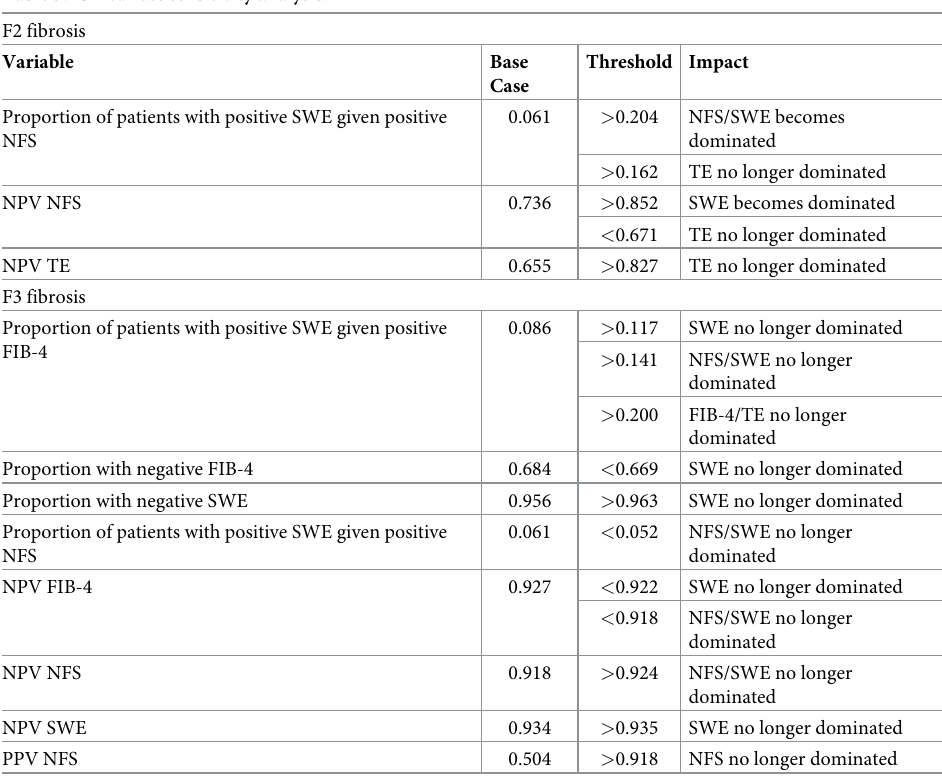
Threshold Impact Case 0.061 > 0.204 NFS/SWE becomes dominated > 0.162 TE no longer dominated < 0.671 TE no longer dominated 0.086 > 0.117 SWE no longer dominated > 0.141 NFS/SWE no longer dominated > 0.200 FIB-4/TE no longer dominated 0.061 < 0.052 NFS/SWE no longer dominated < 0.918 NFS/SWE no longer dominated dominated